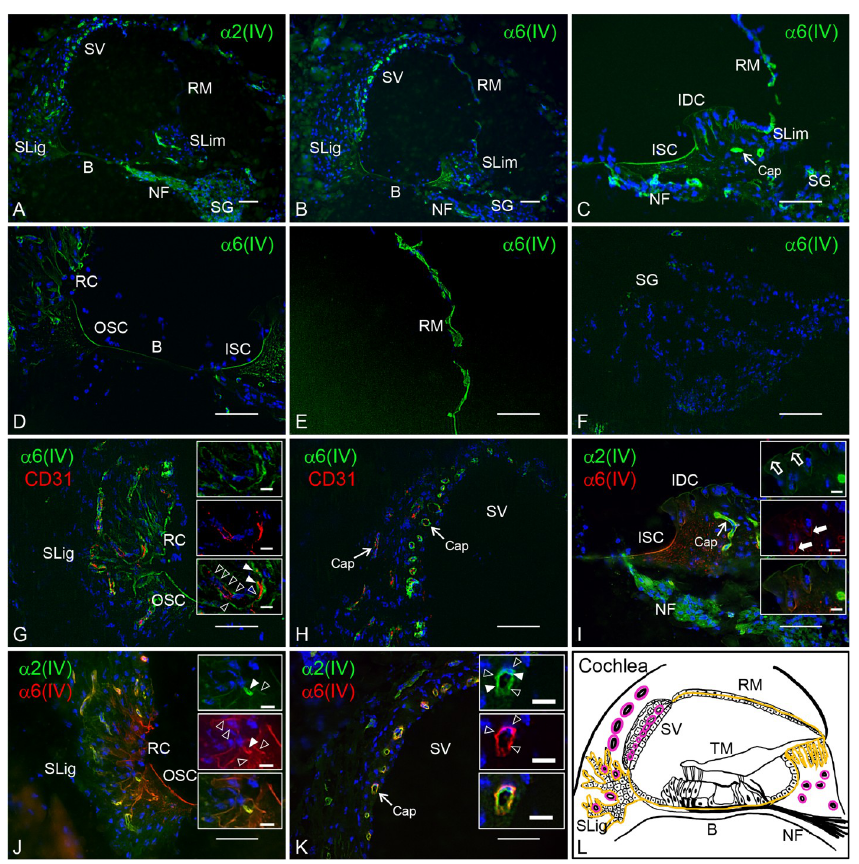
Fig 2. Distribution of collagen α 6(IV) chain in the adult mouse cochlea. Sections were immunostained using antibodies against collagen α 2(IV) (A, I–K: green) and α 6(IV) (B–H: green; I–K: red) chains, and CD31 (G, H: red) for the detection of endothelial cells. Subepithelial BMs and perivascular BMs are indicated by open arrowheads and solid arrowheads in the insets, respectively (G, J, K). (I) The superficial plate and invaginated region of the interdental cells network are indicated by open arrows and solid arrows in insets, respectively. (L) Schematic diagram of the distribution of collagen α 6(IV) chain [yellow line: subepithelial BMs; pink line: perivascular BMs]. The negative control was established by immunostaining with only the secondary antibody and no specific reaction was observed (S2 Fig). Nuclei were counterstained with Hoechst 33258 (blue). SLim: spiral limbus; B, basilar membrane; SLig, spiral ligament; SV, stria vascularis; RM, Reissner’s membrane; NF, neural fasciculus; SG, spiral ganglion; IDC, interdental cells; ISC, inner sulcus cells; OSC, outer sulcus cells; RC, root cells; Cap, capillary. Scale bars = 50 μ m. Scale bars in inset = 10 μ